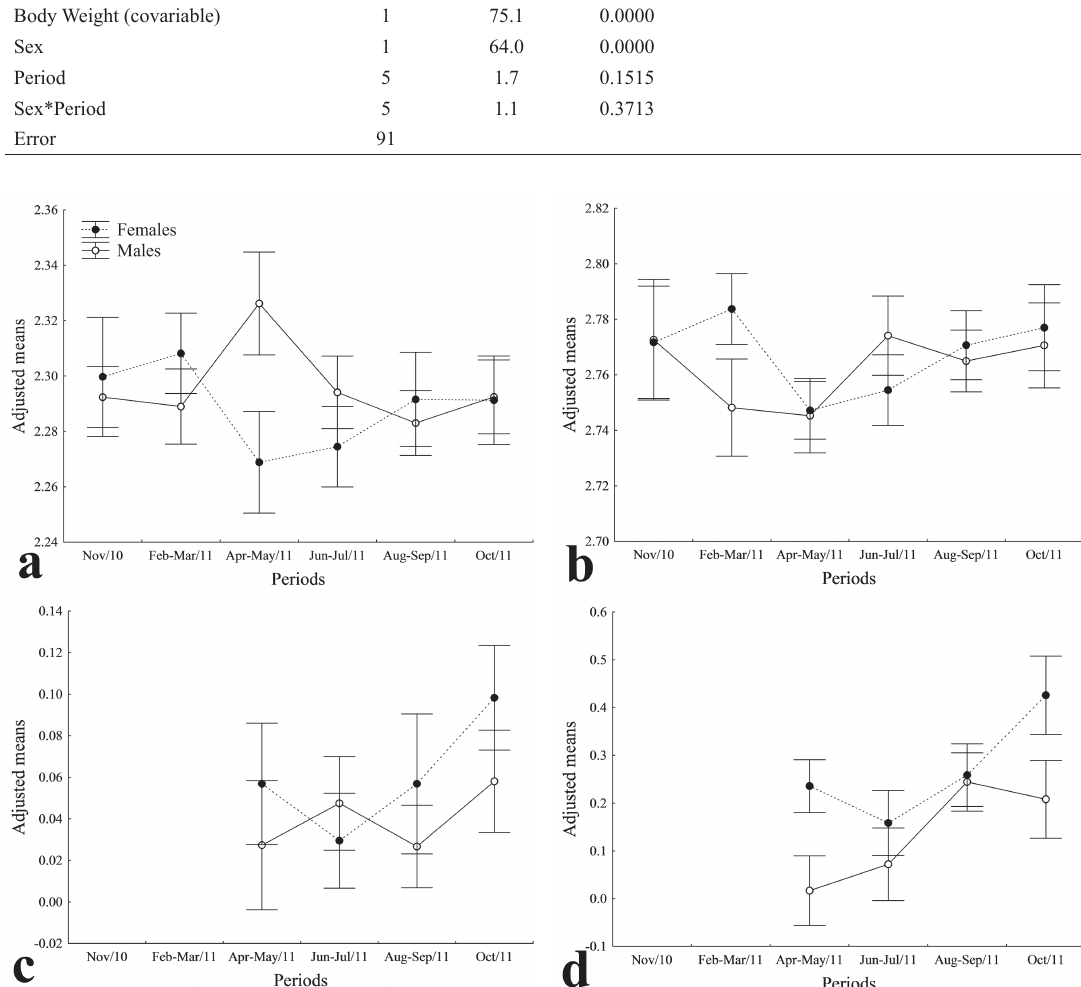
Fig. 6. Temporal variation in body condition and fat storage for immature (a and c respectively) and adult fish (b and d respectively of Cichla piquiti ). These figures show adjusted means ±SE derived from an Analysis of Covariance (see Table 4).